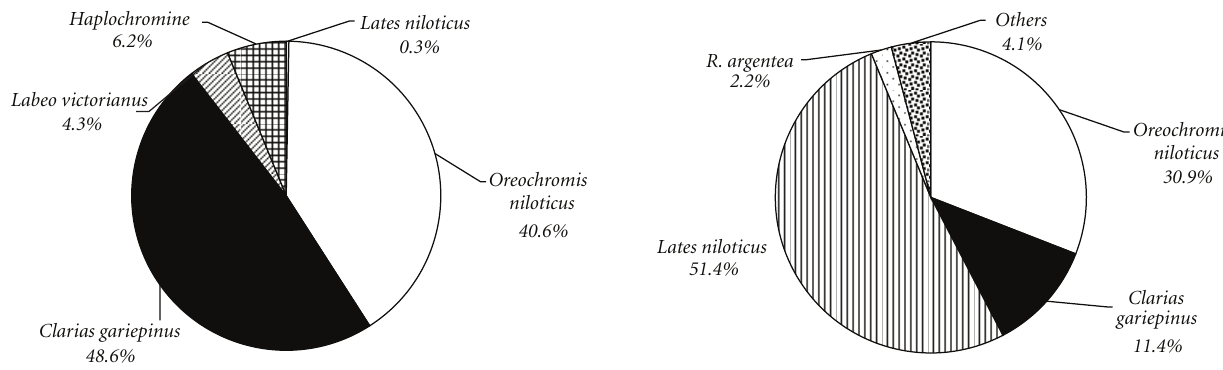
Figure 10: Percent (%) composition of the fish species in the open water